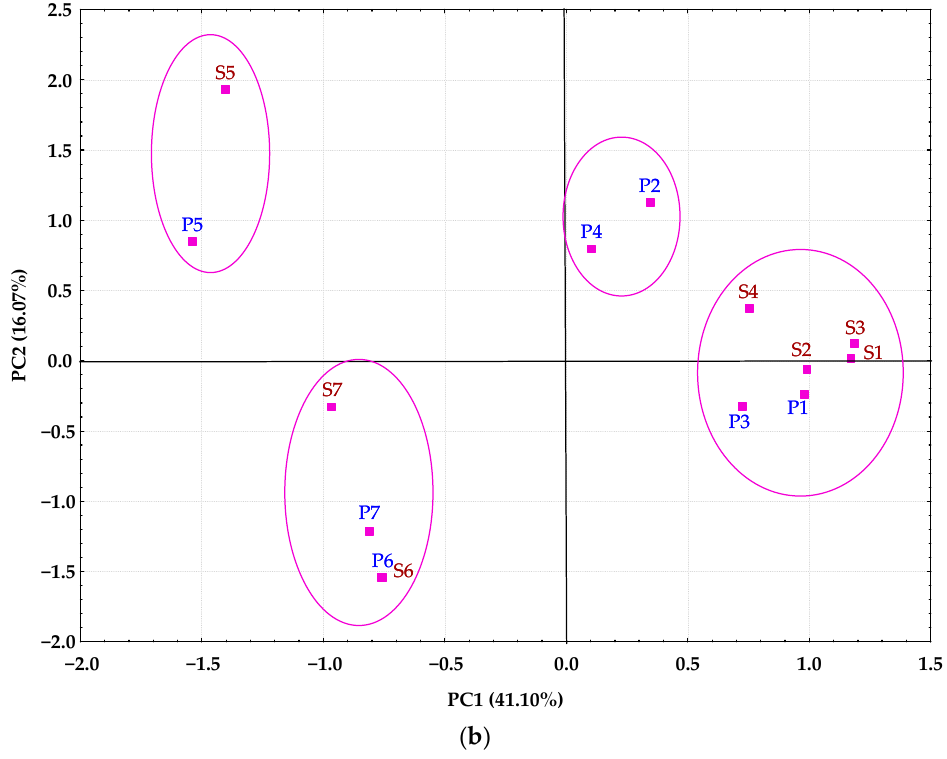
Figure 8. Principal component analysis (PCA) calculated on 23 volatile compounds. ( a ) Variable loadings. Codes of components are shown in Table S1; ( b ) Sample scores. Plum spirits of Požega č a (P) and Stanley (S) varieties produced by traditional process (P1 and S1) and modified methods (P2–P7 and S2–S7).